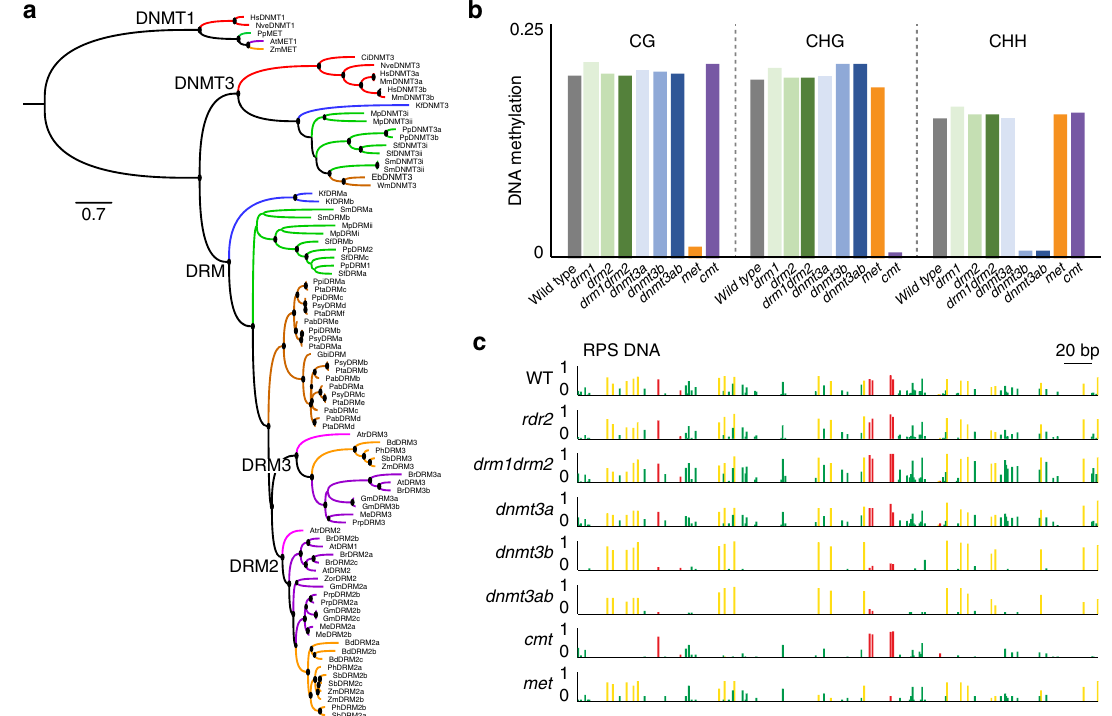
Fig. 1 PpDNMT3b and PpCMT establish DNA methylation and maintain the entire non-CG methylome. a Sequences of DNMT3 and DRM MTD regions were aligned using MUSCLE 64 (Supplementary Fig. 2). The phylogenetic tree was constructed by IQ-TREE 62,63 and illustrated by FigTree. DRM MTDs were reorganized to fi t the linear motif order as in canonical DNMTs. DNMT1 homologs were added as an outgroup. Clades having bootstrap value above 70% are marked with a circle. Protein accessions are listed in Supplementary Table 1. Colors depict taxonomic groups: red – animals; blue – charophytes; green – non-seed land plants; brown – gymnosperms; magenta – basal angiosperms; orange – monocots; purple – dicots. For alignment see Supplementary Fig. 1. b Averaged genomic cytosine methylation of WT and DNMT mutants in three sequence contexts, CG, CHG, and CHH. See Supplementary Table 2 for detailed information. c RPS methylation level (forward strand) in WT and indicated mutants. Red, yellow, and green represent CG, CHG, and CHH methylation, respectively. Source data of Fig. 1c is provided as a Source Data fi